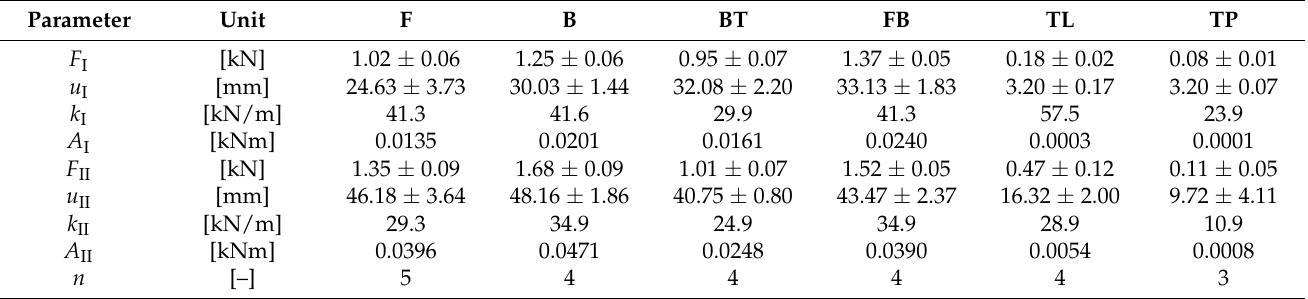
Table 1. Data from laboratory test.